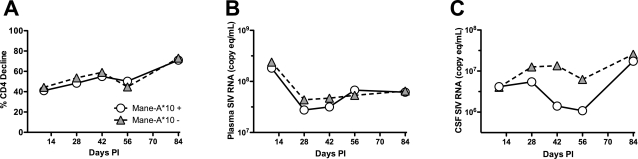
Mane-A*10 expression did not influence CD4+ T cell decline or plasma viral load but was associated with lower CSF viral loads.Comparing longitudinal trends in CD4+ T cell decline from baseline pre-infection values and plasma SIV RNA demonstrated that Mane-A*10 expression was not associated with either extent of CD4+ T cell decline throughout infection (A) or with altered plasma viral load set points in untreated SIV-infected macaques at any time point from primary through asymptomatic to terminal stages of (B). To determine whether Mane-A*10 expression was associated with altered viral replication in the periphery, mean plasma viral load throughout infection was measured in untreated SIV-infected animals grouped by Mane-A*10 status (Mane-A*10 positive animals represented by circles, n = 11; Mane-A*10 negative animals represented by triangles, n = 21). Plasma viral load also did not differ significantly between these groups at any time-point from day 14 post-inoculation until terminal sampling (P>0.05). Similarly, Mane-A*10 expression status was not associated with extent of % CD4+ T cell decline in SIV-infected macaques, with no statistically significant difference between groups of animals composed of Mane-A*10 positive animals (circles) versus Mane-A*10 negative macaques (triangles). Combined, these data indicate that neither plasma viral load or CD4+ T cell loss are associated with expression of Mane-A*10 in pigtailed macaques inoculated with SIV/17E-Fr and SIV/DeltaB670. In contrast, mean SIV RNA levels in CSF were lower in the group of Mane-A*10 positive animals (circles) versus Mane-A*10 negative macaques (triangles).